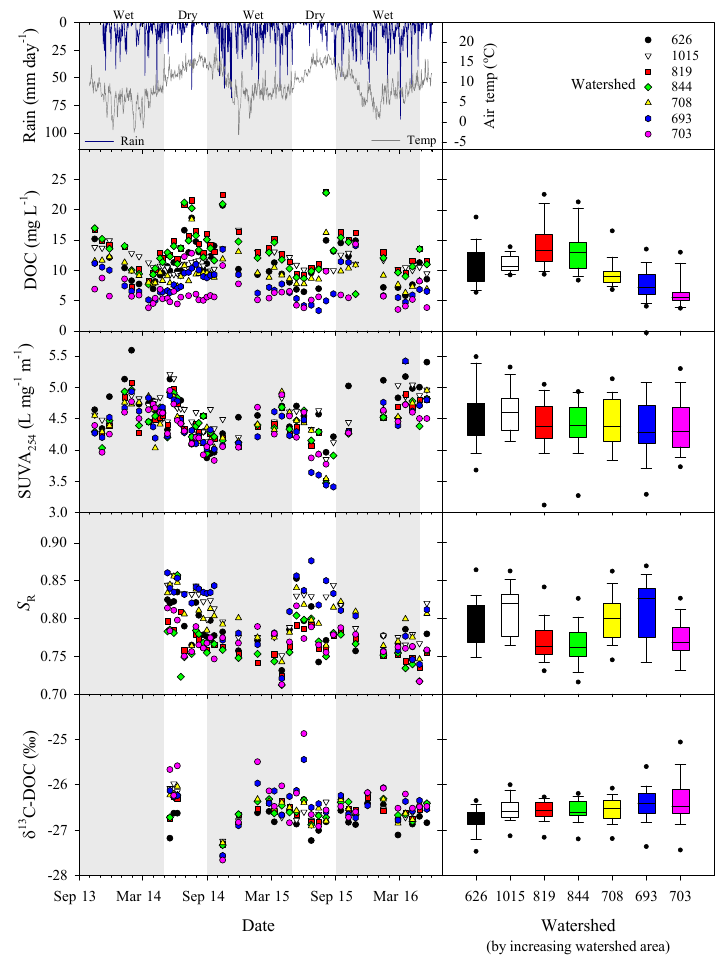
Figure 3. Seasonal (timelines, by date) and spatial (box plots, by watershed) patterns in DOC concentration and DOM composition for stream water collected at the outlets of the seven study watersheds on Calvert and Hecate islands. Boxes represent the 25th and 75th percentile, while whiskers represent the 5th and 95th percentile. Daily precipitation and annual temperature are shown in the top left panel. Grey shading indicates the wet period (1 September–30 April) and the unshaded region indicates the dry period of each water year.